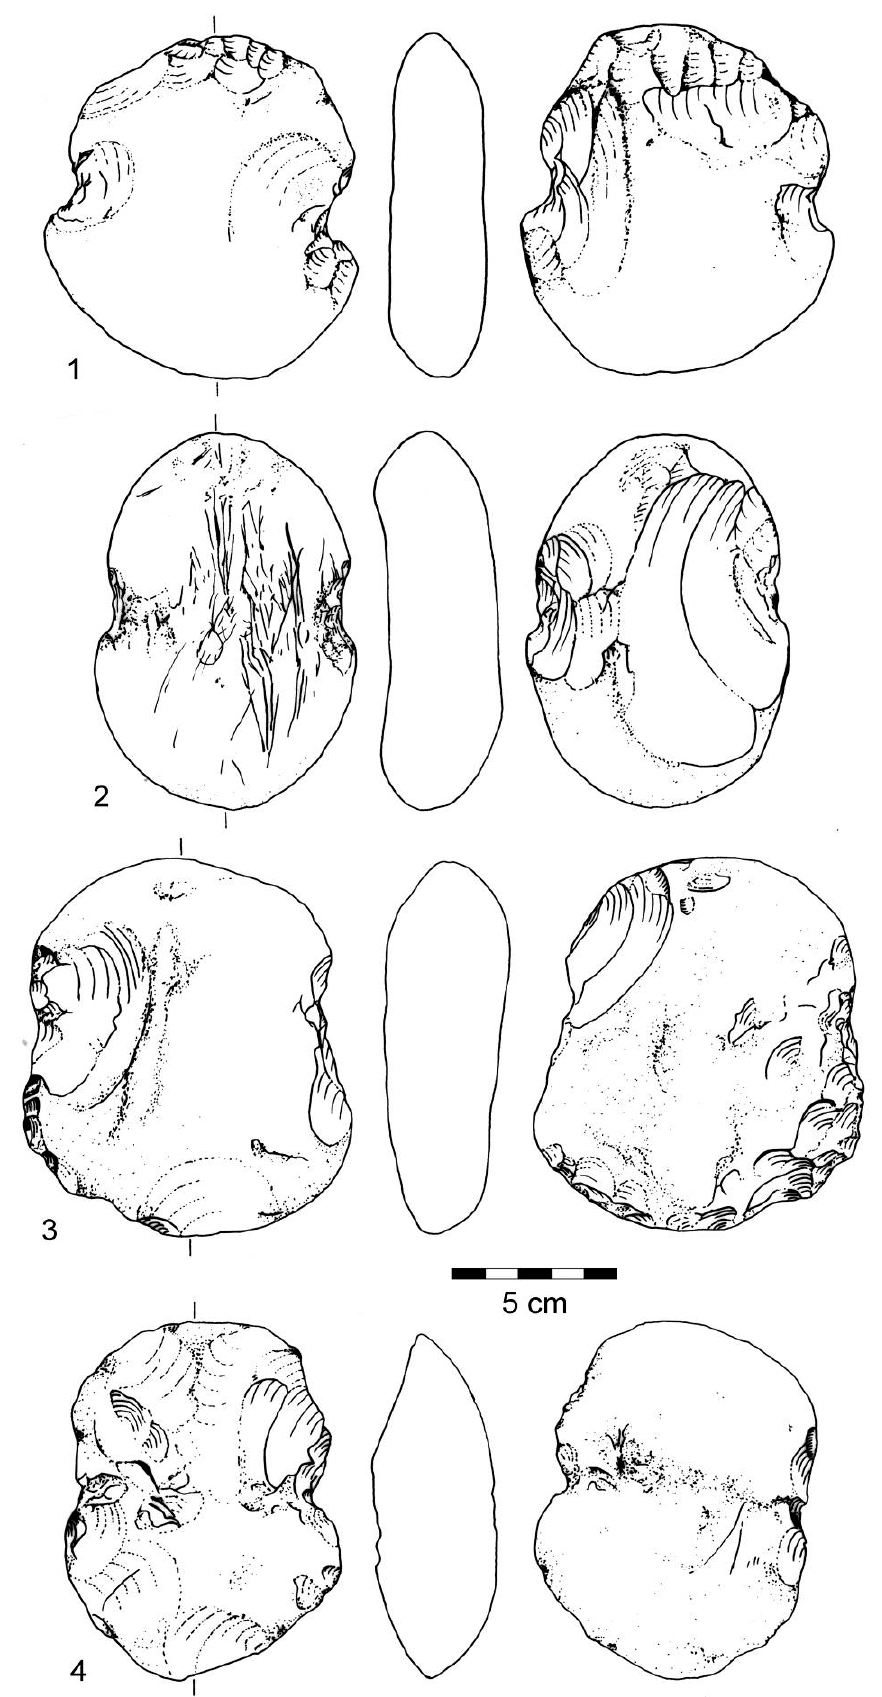
Figure 14. Stone weights from Ohalo II. Note the asymmetrical notches in all, and the incisions on specimen